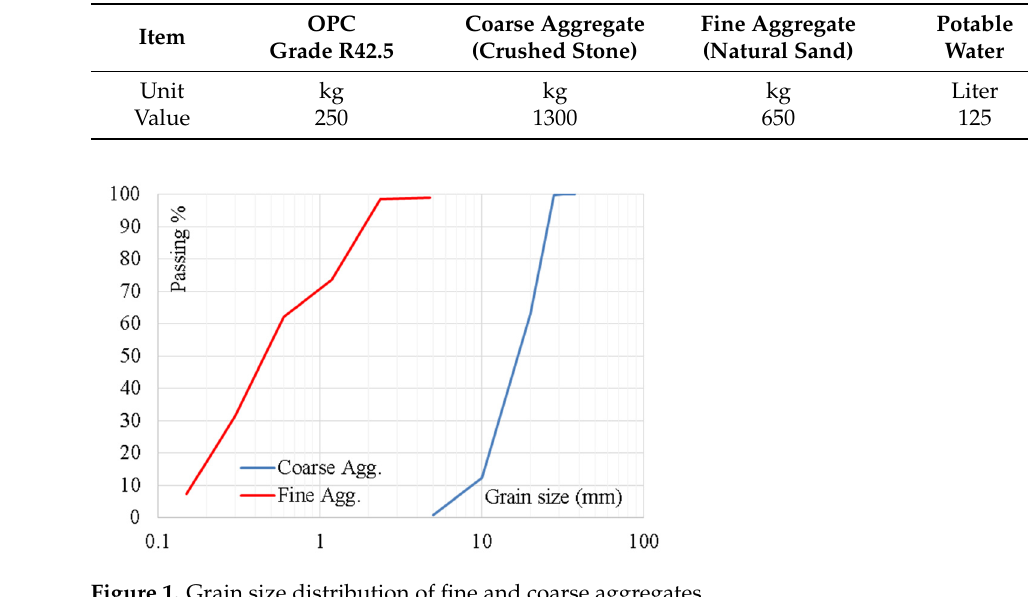
Table 1. The concrete mix proportions (by weight/m 3 ).